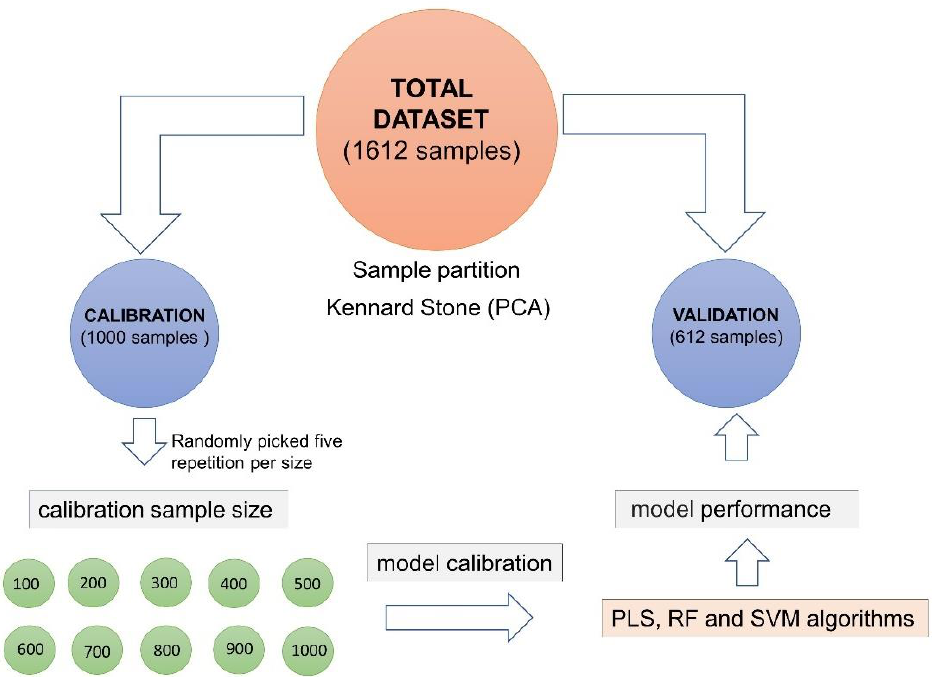
Figure 2. Flowchart of training and validation of the calibration models.